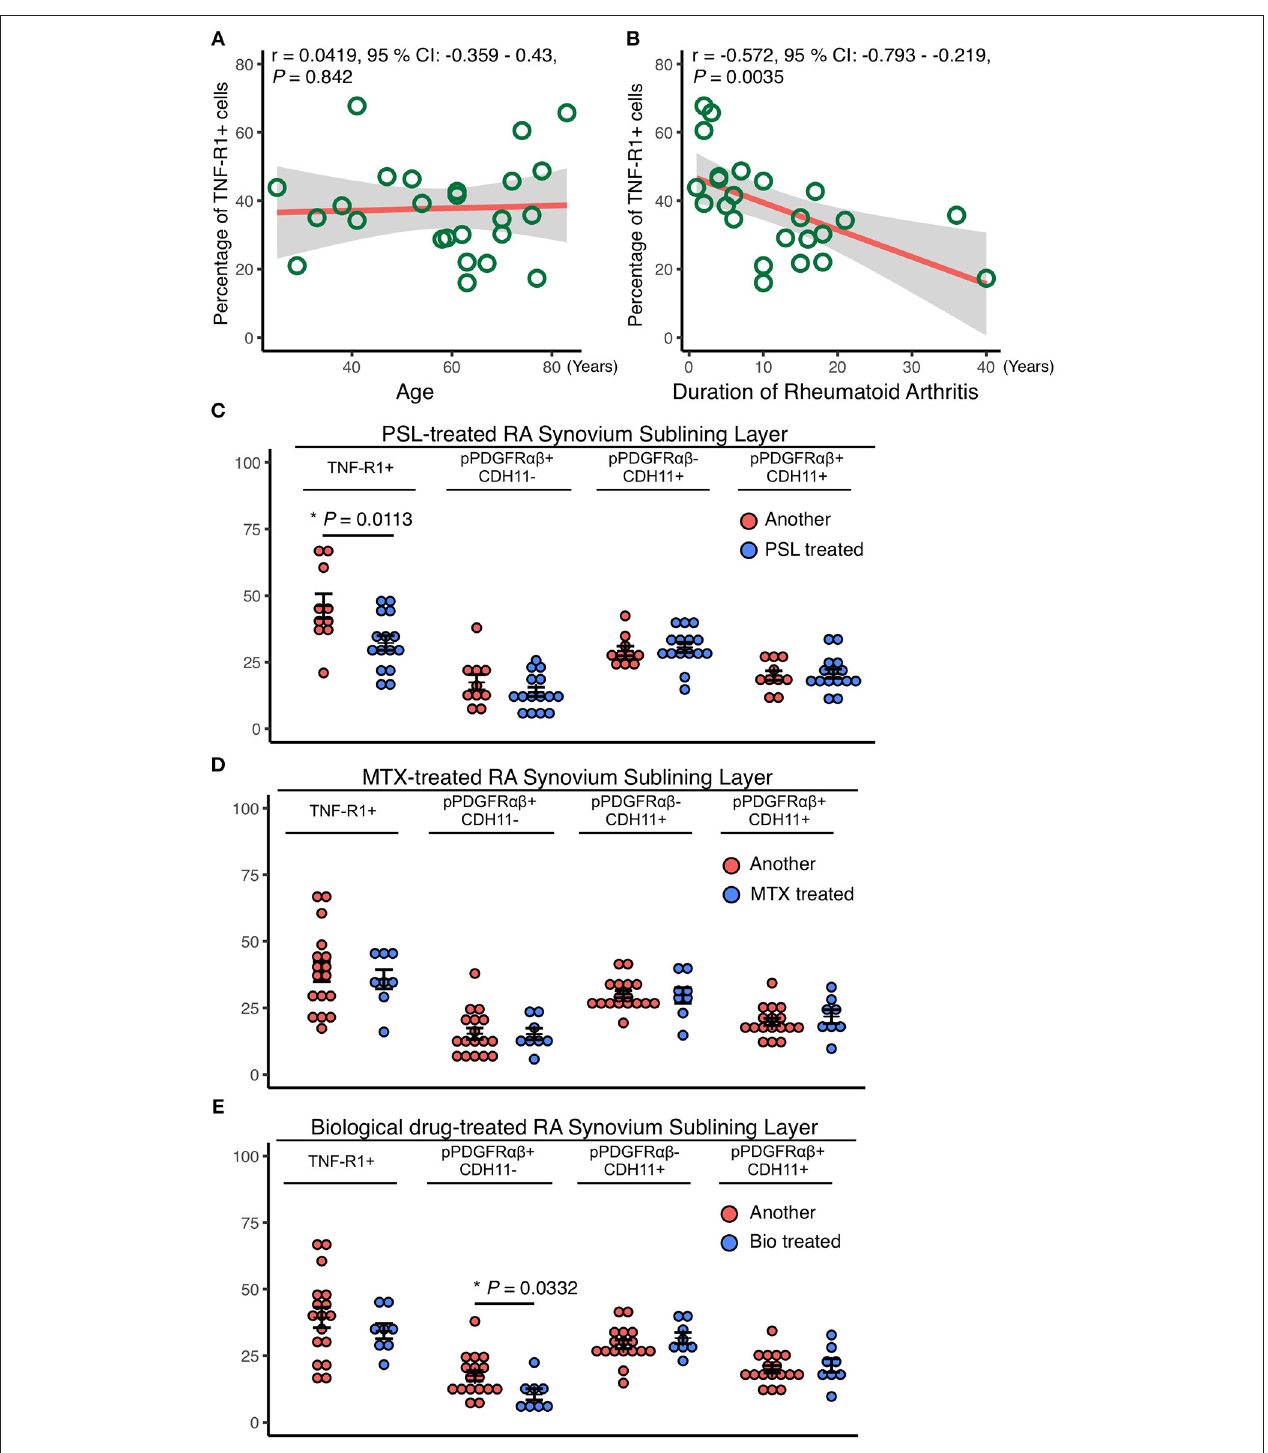
FIGURE 3 | Reduced TNF-R1 expression in the RA-SL was associated with a longer RA duration and the use of prednisolone (PSL). Correlations between the rate of TNF-R1 positivity in the SL and (A) the age of RA patients and (B) RA duration. Although the TNF-R1 positivity rate did not correlate with age, a negative correlation with RA duration was observed. (C–E) the TNF-R1-positive rate in the SL was compared with the percentages of pPDGFR αβ + CDH11–, pPDGFR αβ -CDH11 + , and pPDGFR αβ + CDH11 + cells, depending on whether methotrexate (MTX) or biological drugs were used. (C) although the use of PSL reduced TNF-R1 expression in the SL, significant differences were not observed in the percentages of pPDGFR αβ + CDH11–, pPDGFR αβ -CDH11 + , or pPDGFR αβ + CDH11 + cells. (D) MTX use was